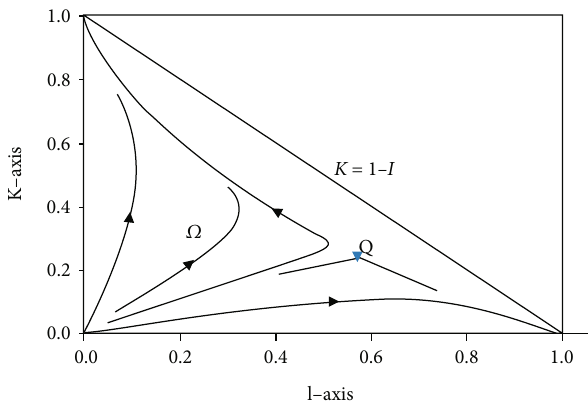
Figure 2: Integral curves of the vector fi eld (10) in the invariant region Ω